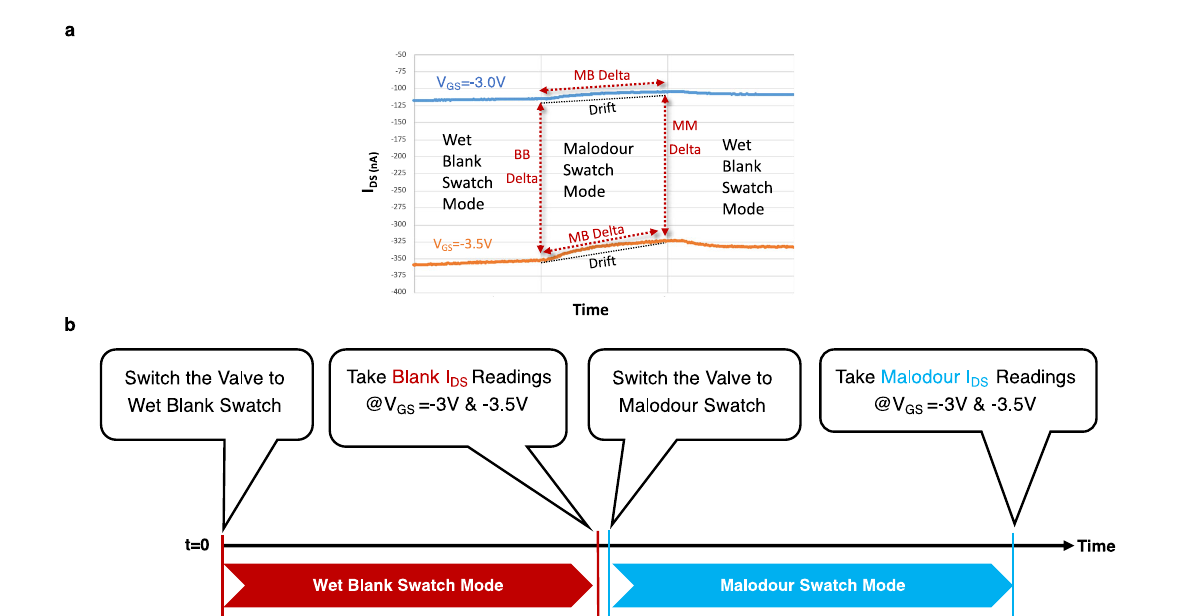
Fig. 4 | Operation modes and measurement protocol. a Delta measurements to mitigate the sensor drift issue across different V GS voltage and swatch modes. MB Delta refers to the I DS difference between the malodour (M) swatch and blank (B) swatchmodesatthesame V GS .BBDeltaand MMDeltarefertothe I DS differenceat thetwo V GS voltagesinthesamemode. b Thebasicmeasurementprotocolisshown